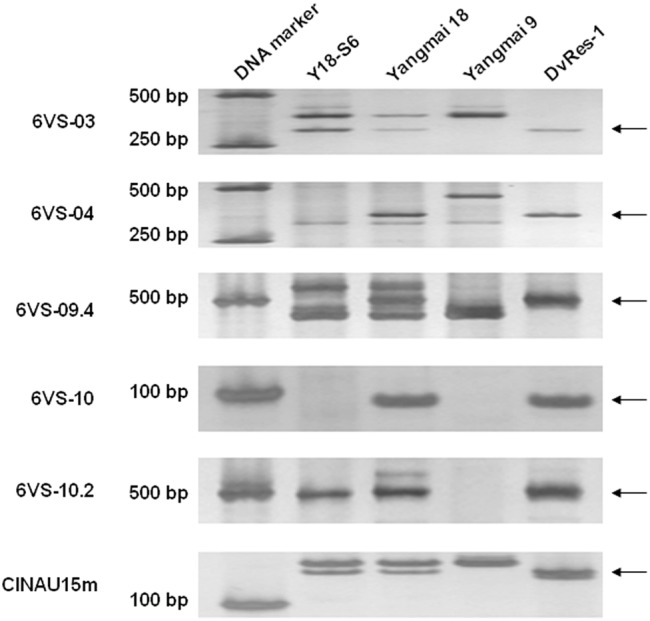
PCR amplification patterns of six representative markers (6VS-03, 6VS-04, 6VS-09.4, 6VS-10, 6VS-10.2, and CINAU15m) used for physical mapping of Pm21. The DNA templates used here are successively the susceptible deletion line Y18-S6, Yangmai 18, Yangmai 9, and the resistant D. villosum line DvRes-1. The 6VS-specific DNA bands are pointed by arrows.